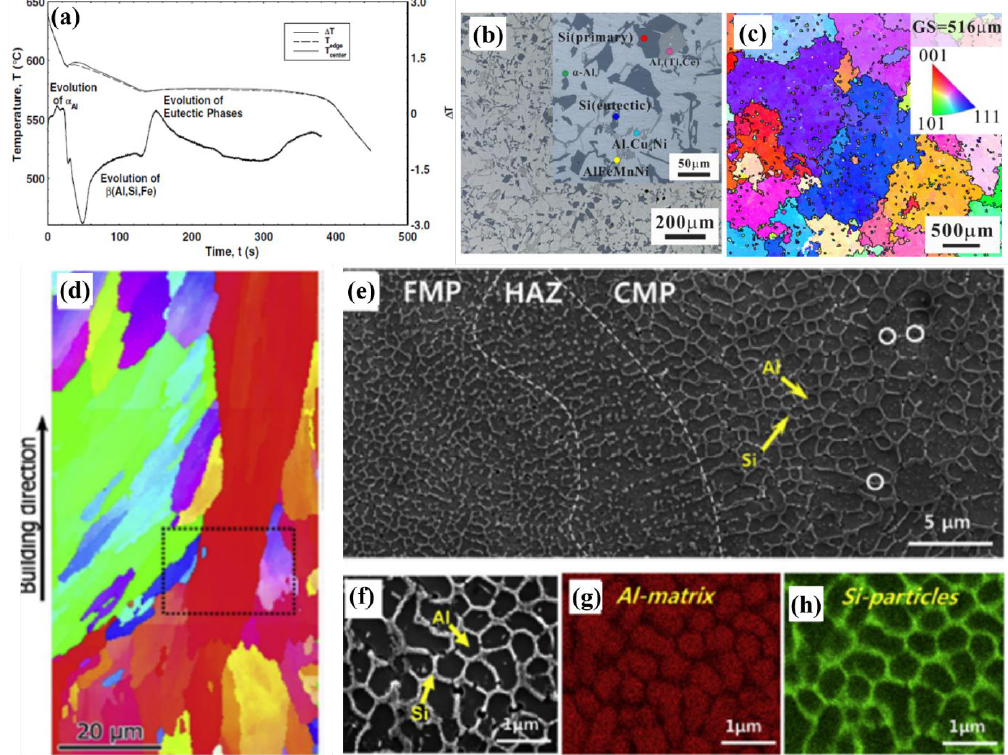
Figure 4. Cooling curve showing the sequence of the phase evolution during solidification for ( a ) Al − 8.5%Si − Fe alloy [166]. ( b , c ) Optical and EBSD microstructures for gravity cast Al − Si piston alloy, respectively [173]. ( d ) EBSD − inverse pole figure map showing columnar grains for L − PBF Al − 10%Si − Mg alloy [175]. ( e , f ) Cellular microstructures for SLMed Al − 10%Si − Mg alloy with EDS phase analysis showing the elemental distribution of ( g ) Al and ( h ) Si [176]. Reproduced with permission from Elsevier.